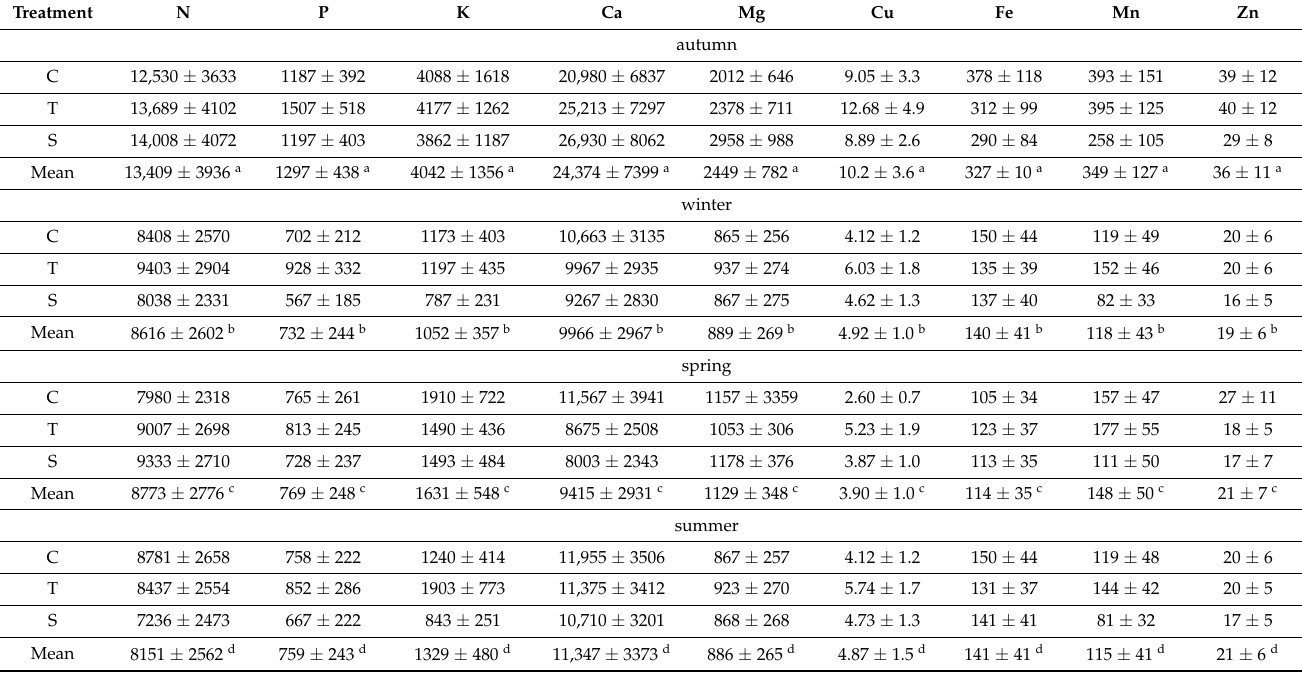
Table 2. Mean seasonal litterfall nutrient concentrations (mean ± SD) expressed as mg · kg − 1 of